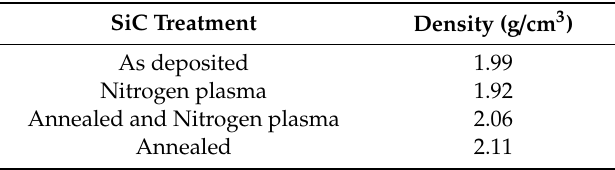
Table 2. Density of SiC film determined by